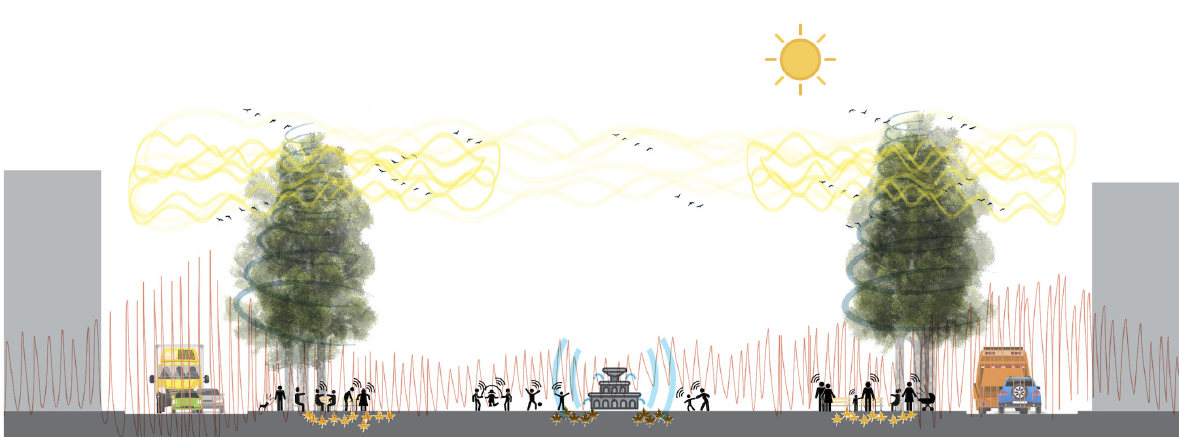
Figure 5: The sounds of the Piazza during an afternoon, June 21st 2017, 12 am. The observation lasted 40 mins. Yellow wavy signs on top of trees point out the presence of birds, a powerful presence; red lines represent the sound of vehicles. Notice the choice of a visualization in vertical section, allowing a visualization of sounds whose source is in fact out of sight.